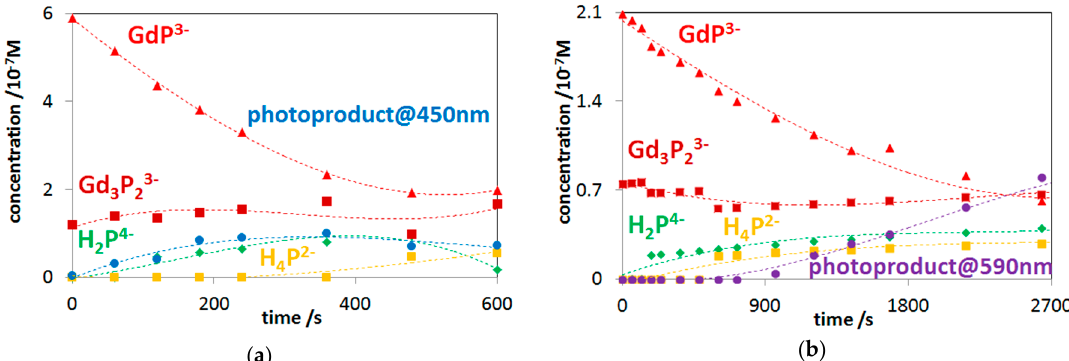
Figure 8. Concentration change of all starting species and the photoproducts at ( a ) Soret-band and ( b ) Q-band irradiations.